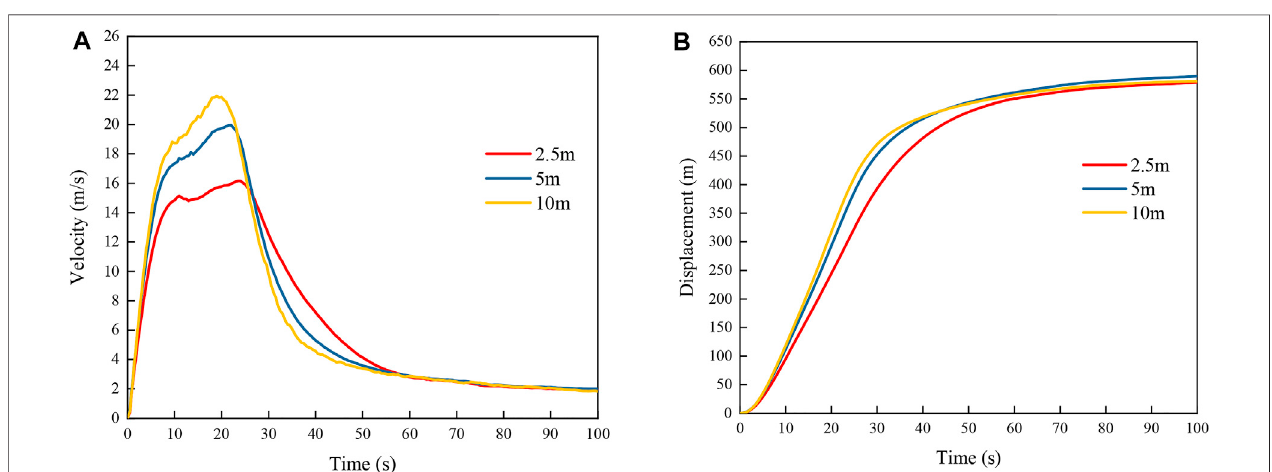
FIGURE 15 | (A) Average velocities and (B) displacements under different mesh